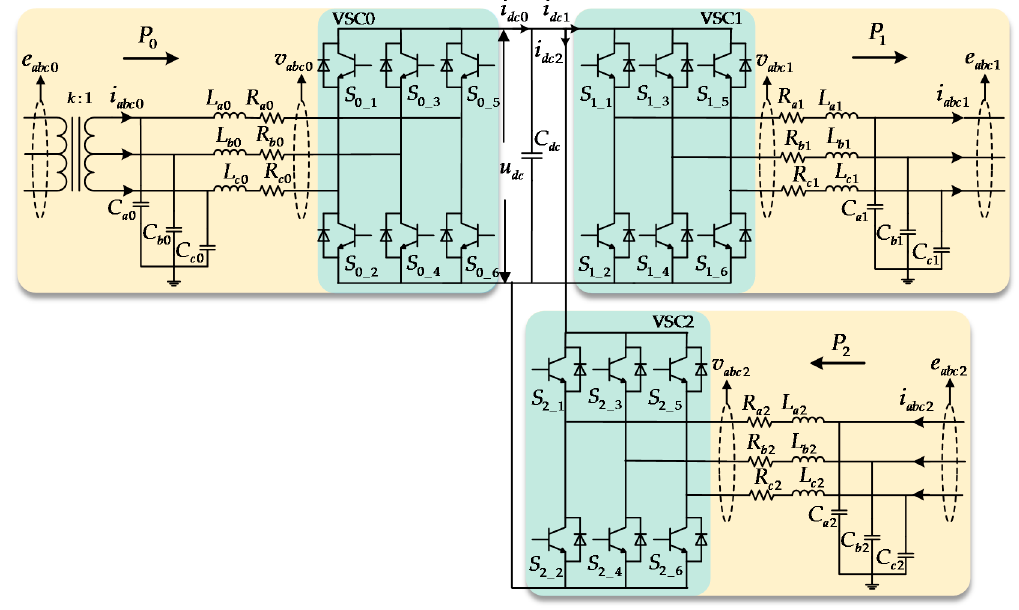
Figure 4. The detailed topology of the energy router.